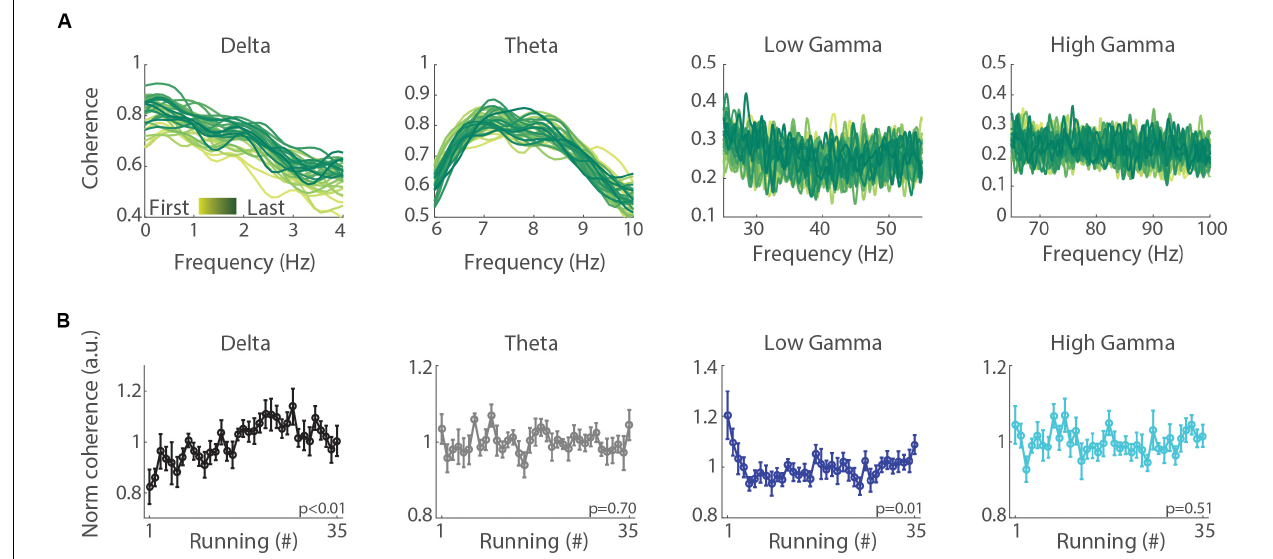
FIGURE 5 | Inter-hemispheric delta coherence increases across treadmill runs. (A) Mean inter-hemispheric phase coherence in the delta, theta, low gamma and high gamma bands for each of the 35 runs. First to last runs are represented in lines colored from yellow to green shades. (B) Normalized mean inter-hemispheric coherence in the delta, theta, low gamma and high gamma bands. Circles denote means and error bars represent ± SEM ( n = 11 sessions from three animals). The normalization was performed for each session by dividing coherence values on each running by the average across all the runs of the session. Notice that mean delta coherence significantly increases across runs ( p < 0.01, repeated measures ANOVA), while mean theta and high gamma coherence presented no significant change ( p = 0.70, p = 0.51, repeated measures ANOVA) and low gamma coherence tended toward a decrease ( p = 0.01).